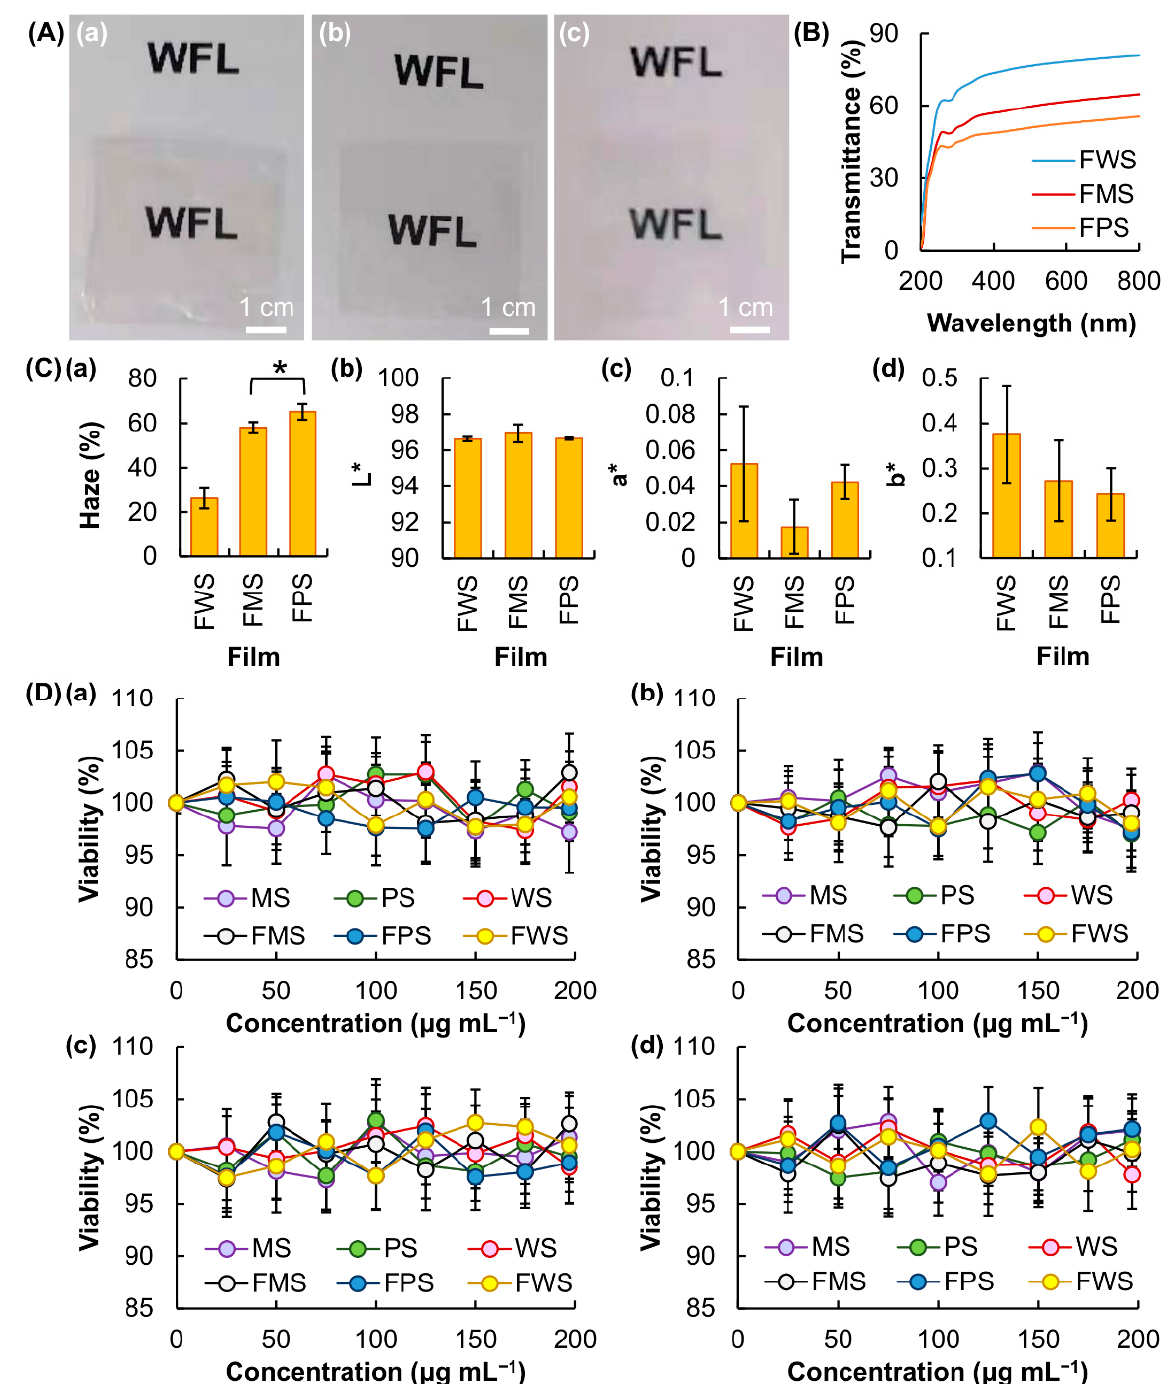
Figure 3. ( A ) Optical images showing the transparency of ( a ) FWS, ( b ) FMS and ( c ) FPS. ( B ) UV-Vis transmittance spectra of different films. ( C ) ( a ) Haze values, ( b ) lightness values (L*), ( c ) red- ness/greenness values (a*) and ( d ) yellowness/blueness values (b*) of different films. * p < 0.05. ( D ) Viability of ( a , b ) HEK293 and ( c , d ) 3T3 fibroblasts after 5 h of treatment with different samples (viz., WS, MS, PS, FWS, FMS, and FPS) ( a , c ) before and ( b , d ) after 24 h of post-treatment incubation.